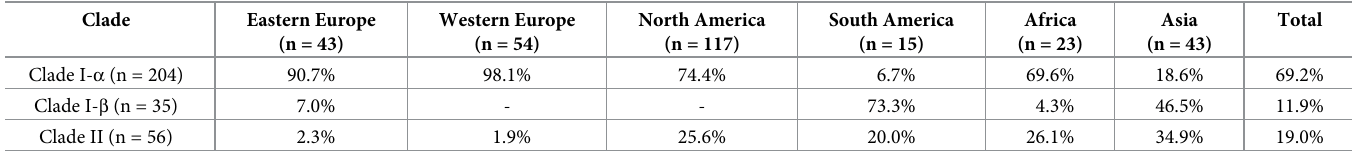
Table 1. Clade composition of CC180 serotype 3 isolates by geographic location. Percentages are based on 295 isolates with available collection date and country.